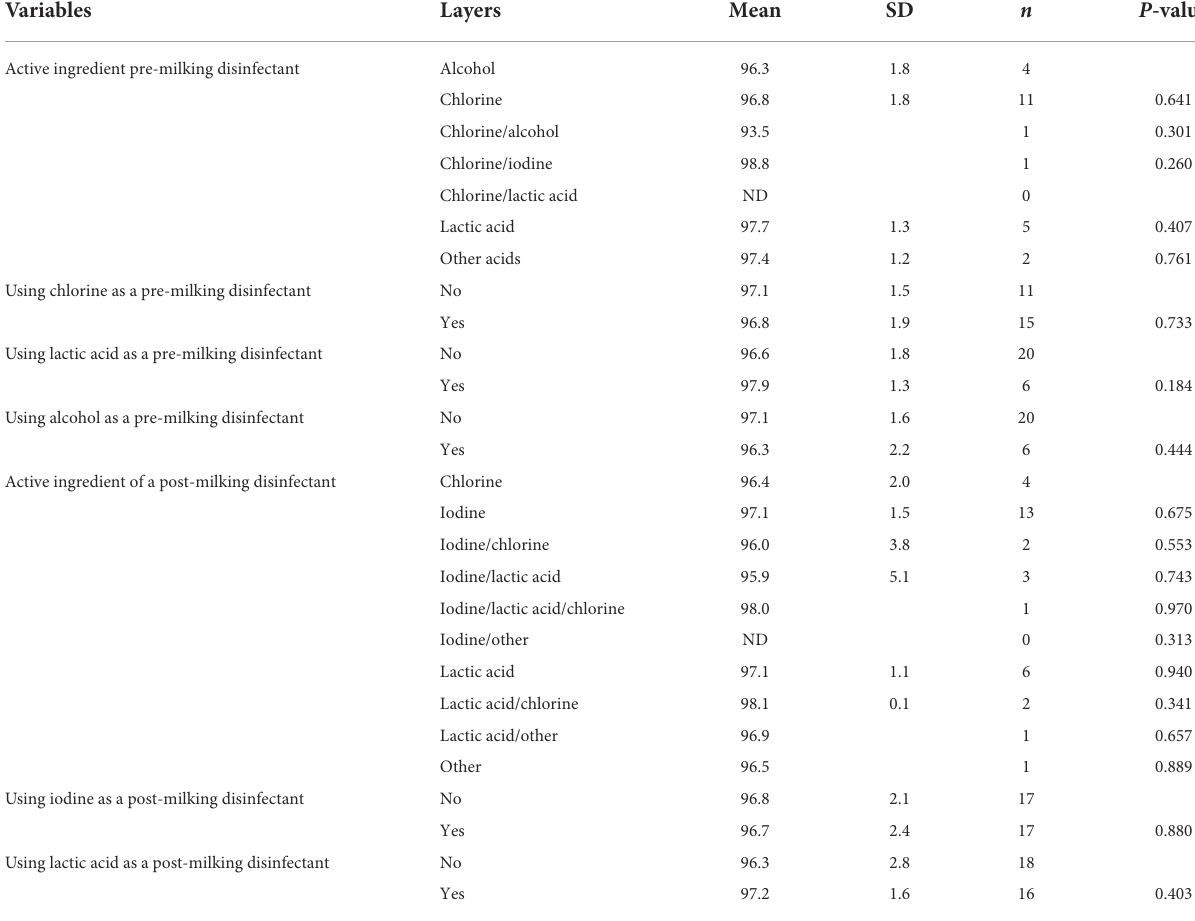
TABLE 5 Relationships between the share of marketed milk (%) and pre- and post-milking disinfectants. Variables Layers Mean SD